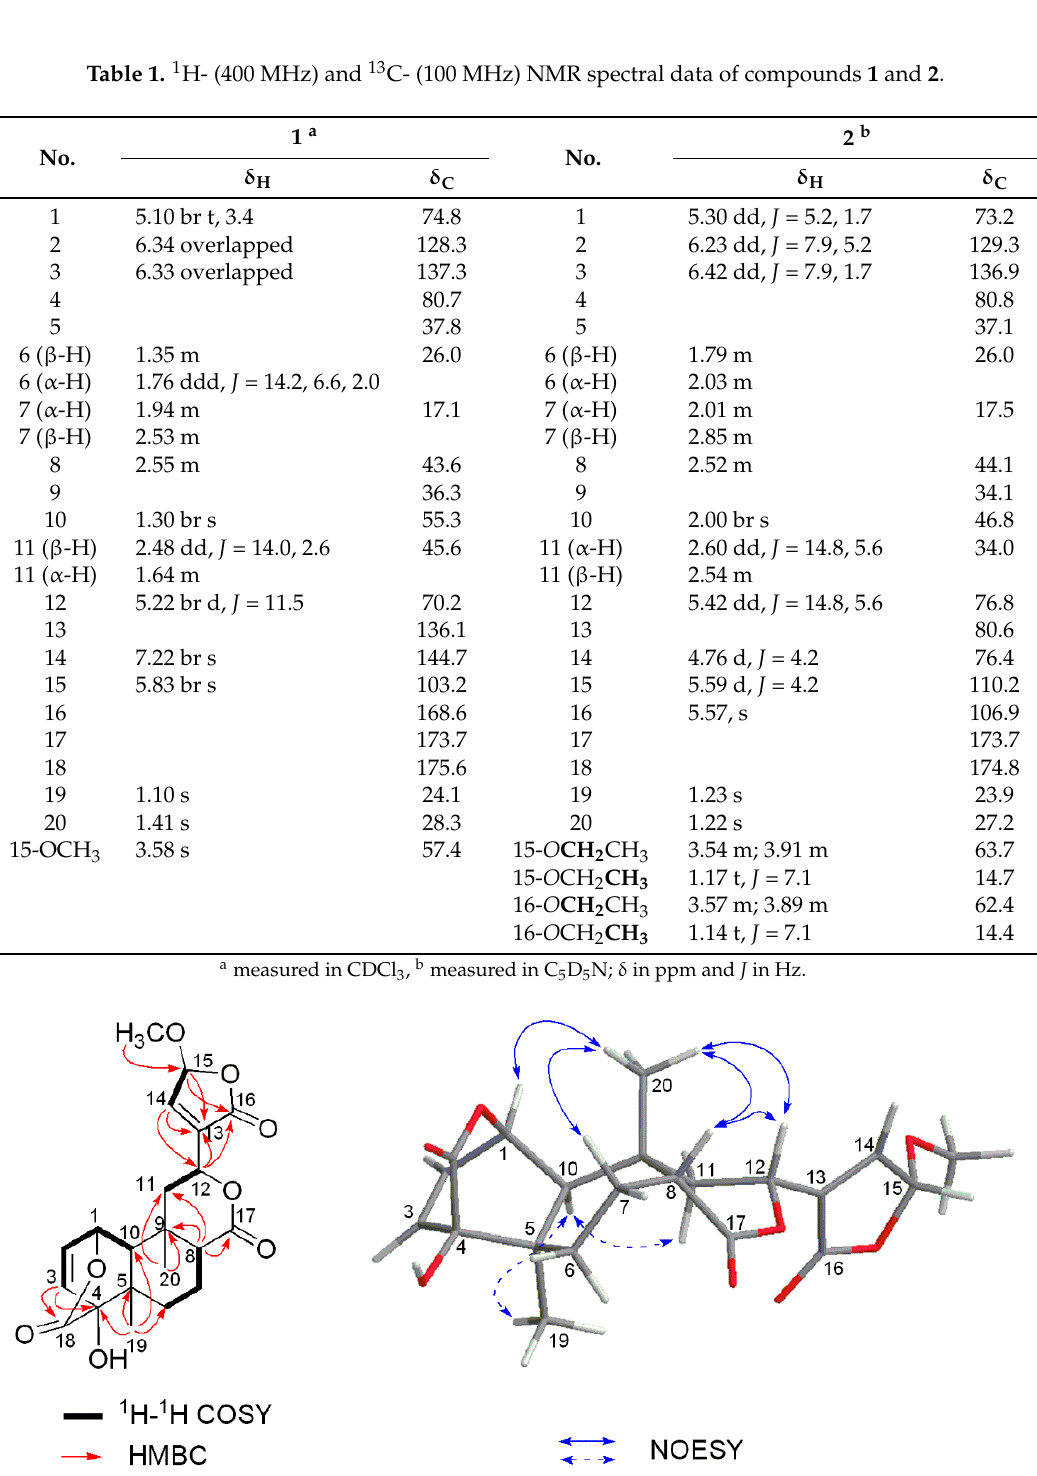
Table 1. 1 H- (400 MHz) and 13 C- (100 MHz) NMR spectral data of compounds 1 and 2.